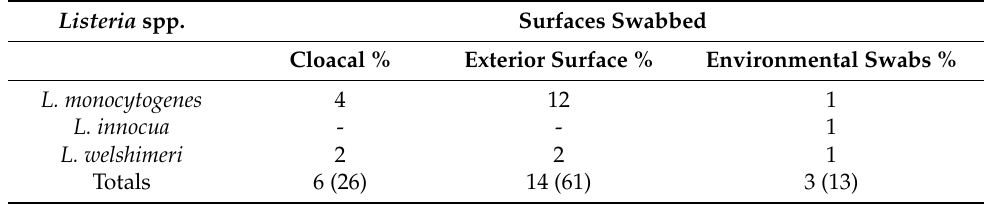
Table 4. Isolation of Listeria spp. from the different surfaces swabbed ( n = 23). Listeria